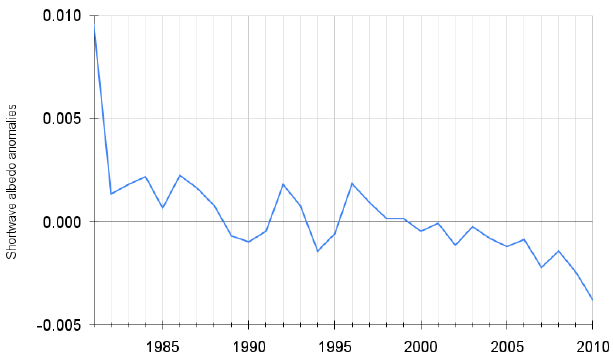
Figure 1. July shortwave terrestrial albedo time series from GLASS data for the Northern